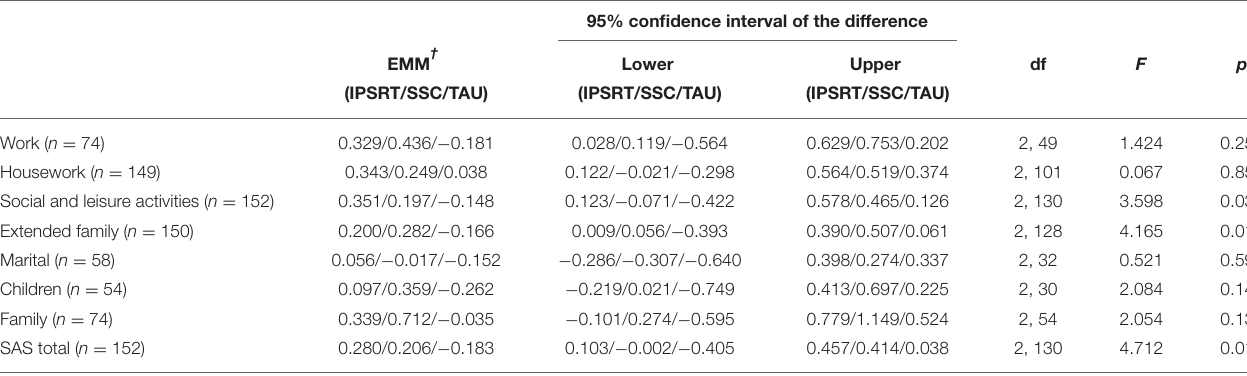
95% confidence interval of the difference